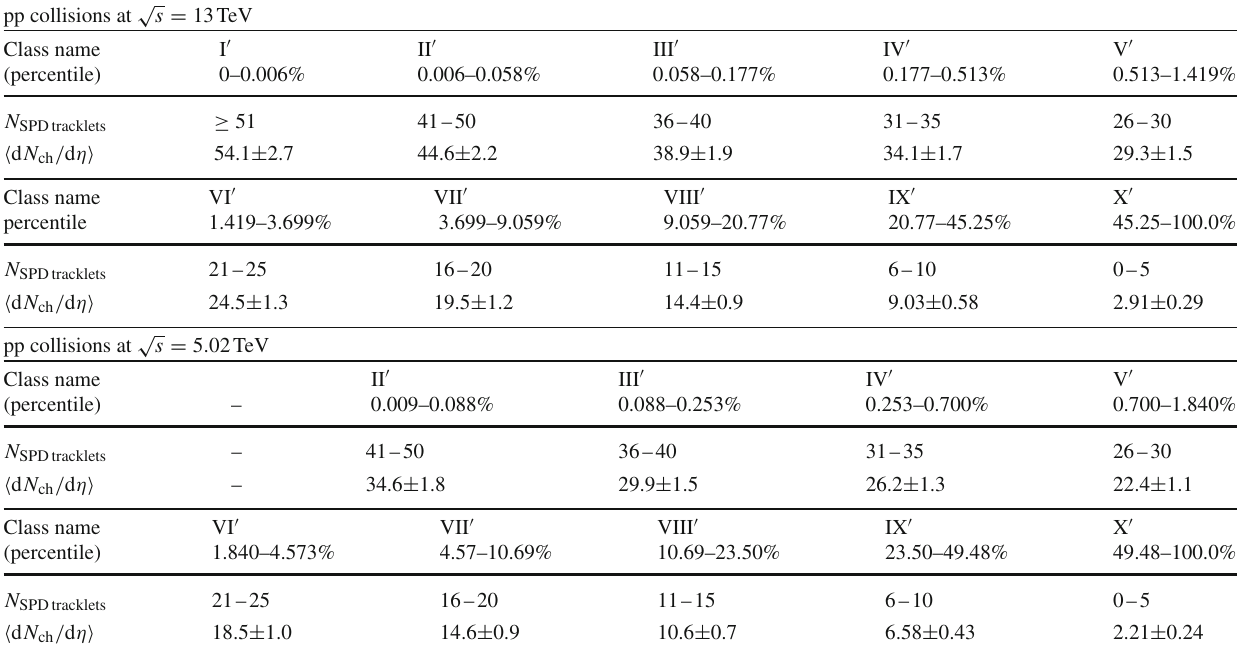
Table 2 Event multiplicity classes based on the number of tracklets ( N SPDtracklets ) within | η | < 0 . 8, their corresponding experimental definition and their corresponding (cid:3) d N ch / d η (cid:4) in | η | < 0 . 8. The uncertainties are the quadratic sum of statistical and systematic contributions √ s = pp collisions at